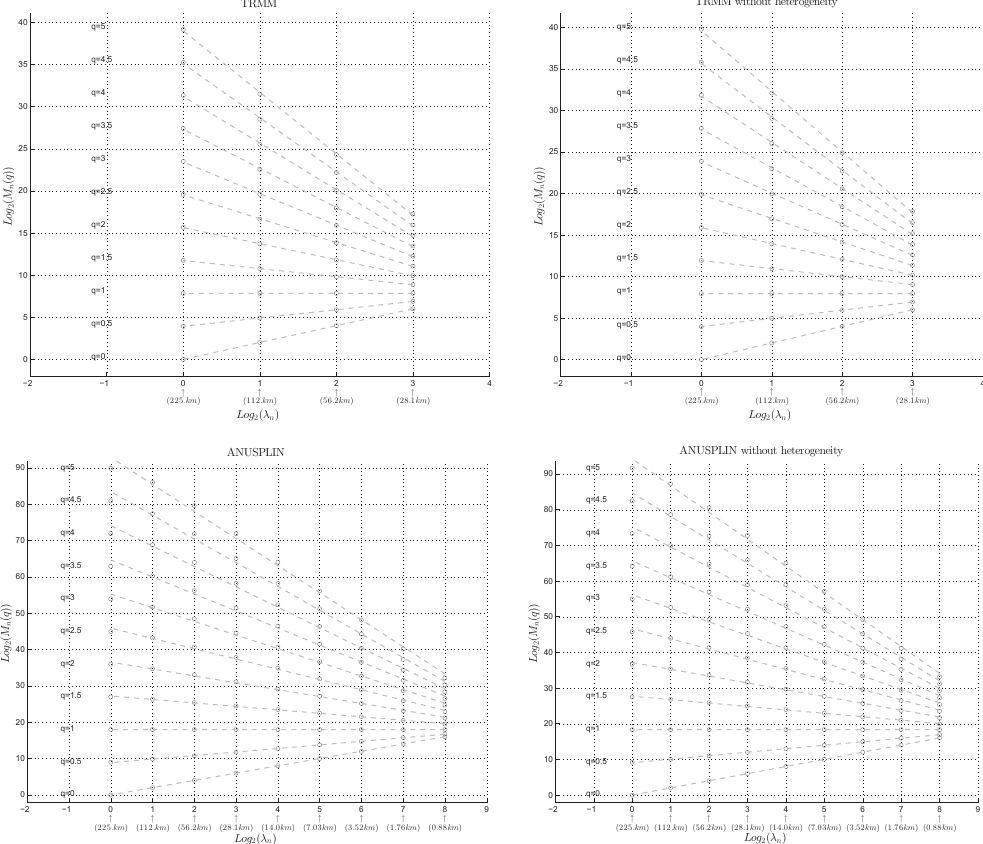
Figure 6. Multifractal linear analysis of TRMM and ANUSPLIN data for 26 February 1999 and q values in the range [0, 5].